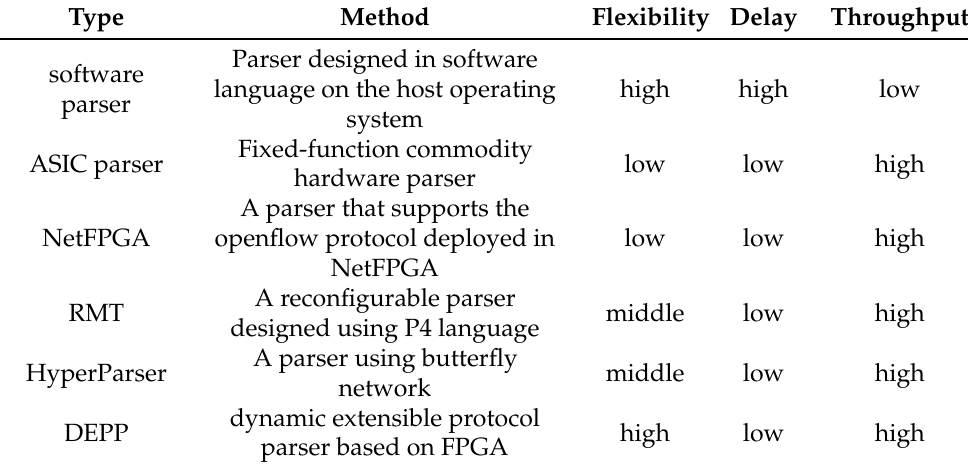
Table 1. Protocol parser performance